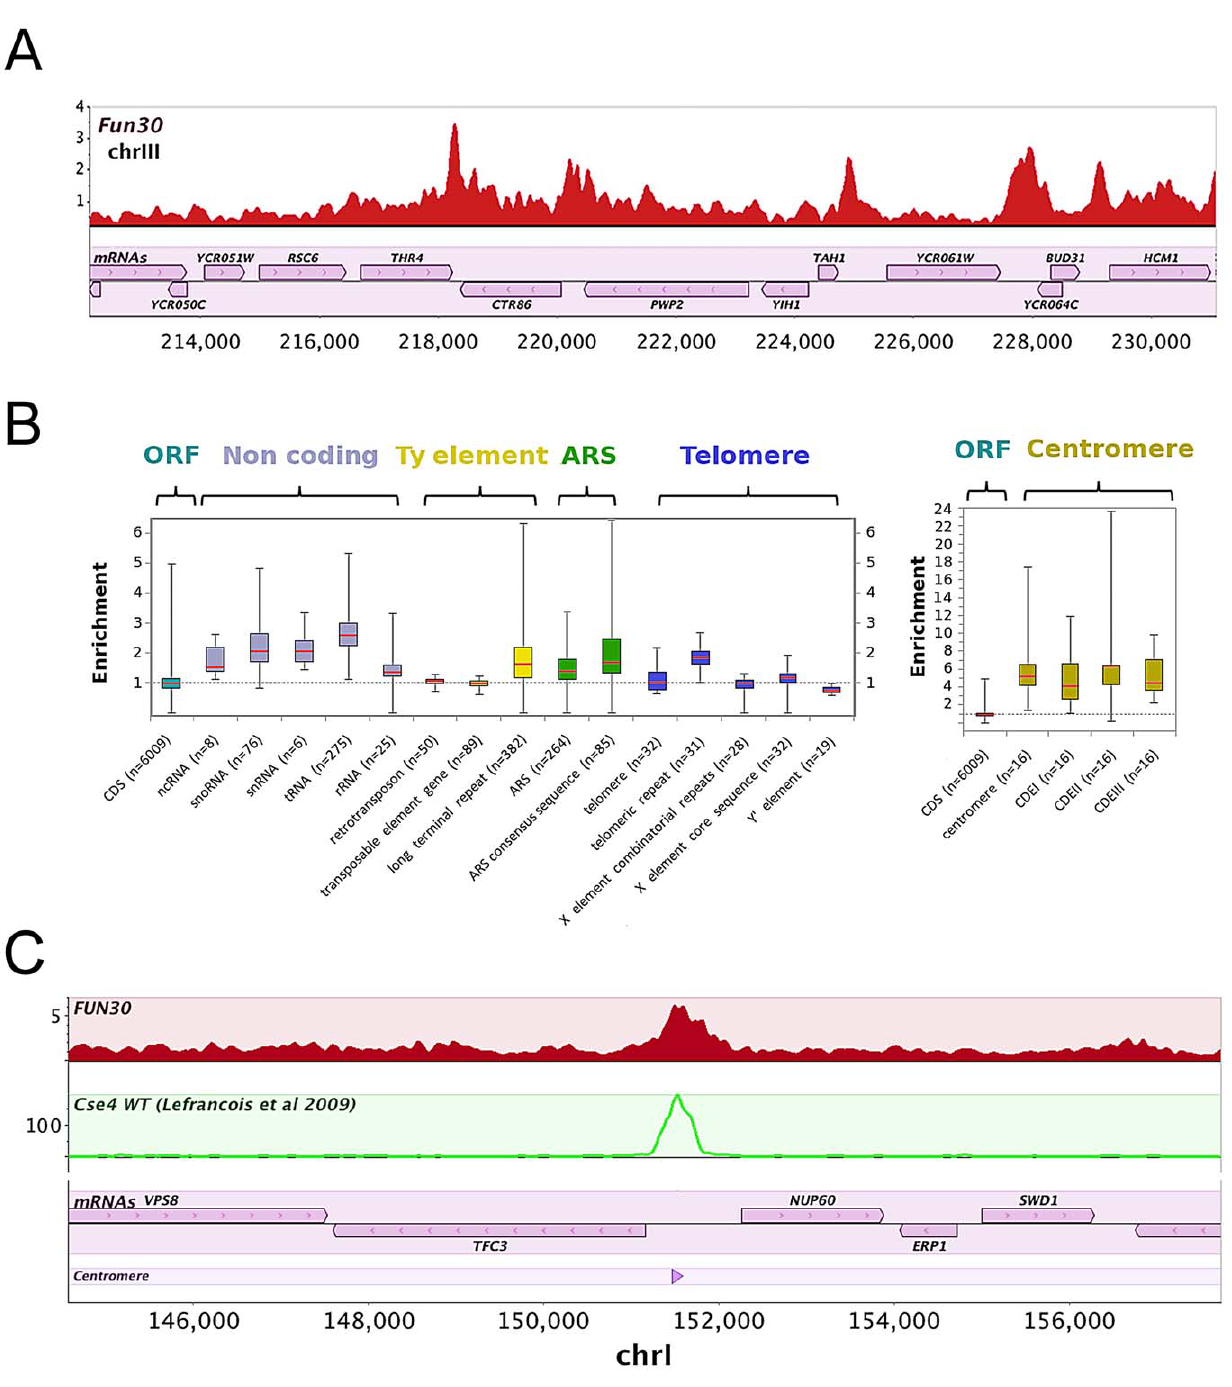
Figure 1. Fun30 is localized to specific regions in the genome, including centromeres. A) Overview of ChIP-Seq binding profile of Fun30 for a segment of chromosome III. The lower track of the figure shows open reading frames (ORFs) and their orientations. B) Box plot analysis of Fun30 enrichment over different genomic features. The lines inside the boxes represent the 50 th percentile (the median) values. The bottom and top of the boxes represent respectively the 25 th and 75 th percentile (the lower and upper quartiles, respectively). The ends of the whiskers represent minimum and maximum values. C) Binding profile of Fun30 in a selected region of chromosome I including the centromere. The second track shows the binding profile of Cse4 (ChIP-Seq data extracted from [86]). The bottom tracks show open reading frames (ORFs) and their orientations and the position of centromere CEN1 .